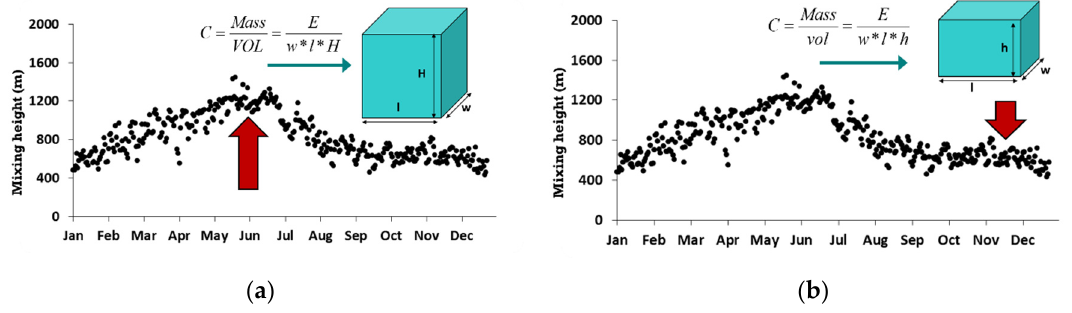
Figure 2. Depiction of a box model pollution calculation with varying inversion heights ( a ) for summer months and ( b ) for winter months.